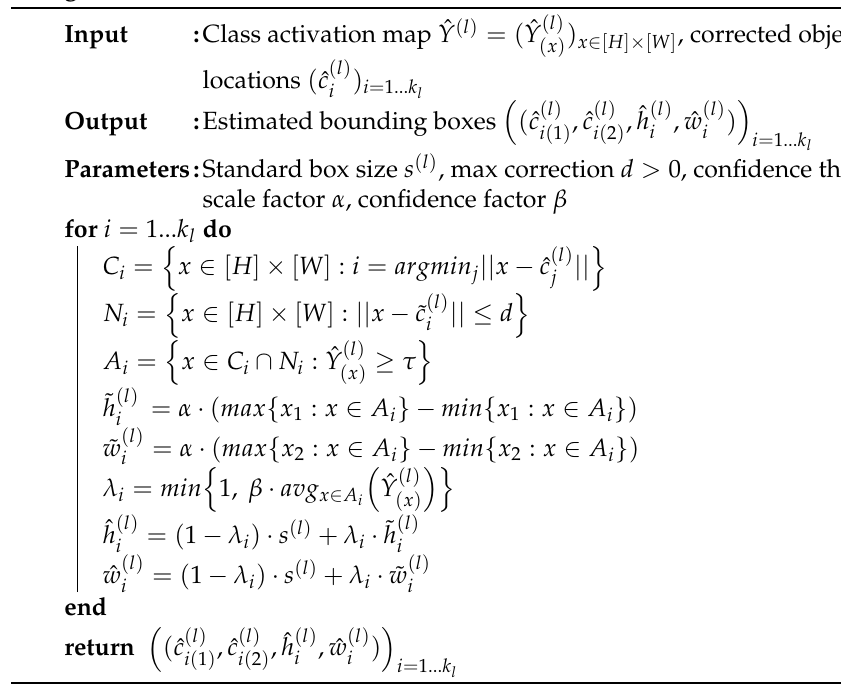
Algorithm 2: Box Size